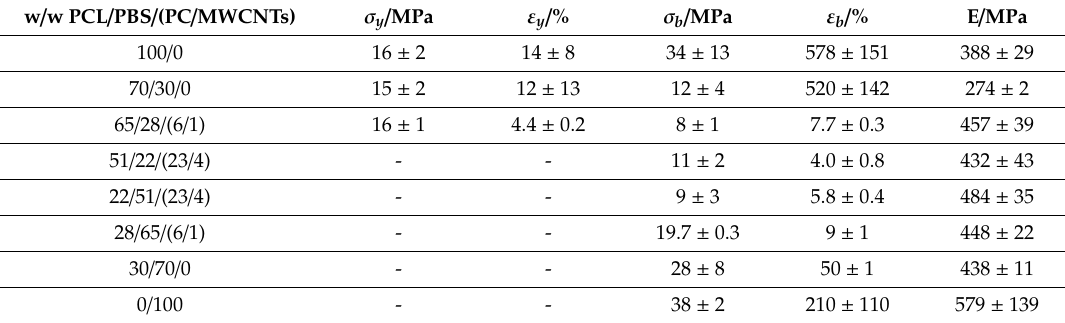
Table 6. Summary of tensile testing results for all the samples.